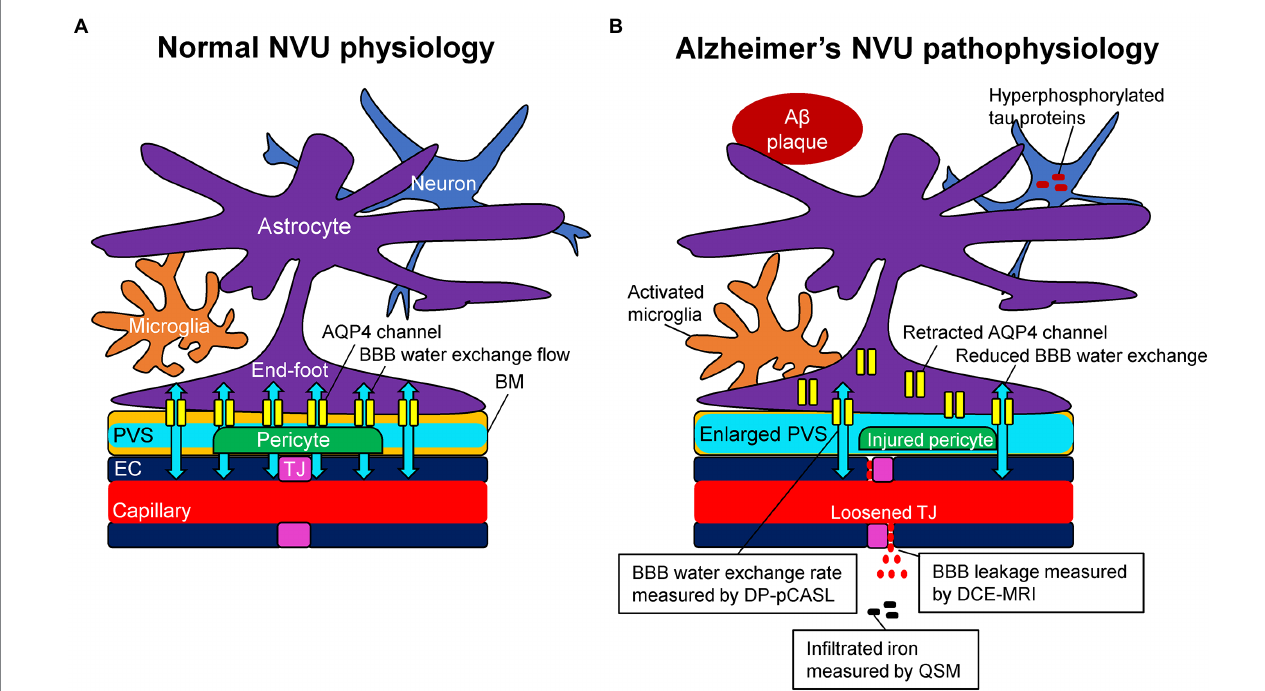
FIGURE 1 Schematic representation of the neurovascular unit (NVU) in normal physiology (A) and Alzheimer’s pathophysiology (B) . (A) The capillary lumen is formed by endothelial cells (EC), pericytes embedded in the basement membrane (BM), and astrocytic end-feet. Tight junction (TJ) proteins seal the ECs together and restrict the passage of solutes into the brain. The BM are separated into two layers, which are attached to the ECs and astrocytic feet, forming the perivascular space (PVS). Aquaporin-4 (AQP4) water channels expressed in the astrocytic end-feet membranes facilitate bidirectional water flow between the capillary, PVS, and interstitial tissues, resulting in the glymphatic flow. (B) In Alzheimer’s pathophysiology, the damaged TJ proteins loosen the seal of the ECs and provide a route for passive diffusion of toxic substances into the extravascular space, which can further damage or downregulate the NVU system. As a consequence of the injured pericyte that normally anchors the AQP4 water channels to astrocytic end-feet, the retraction of AQP4 from astrocytic end-feet membranes occurs with a reduction of bidirectional water flow, resulting in an enlarged PVS. Based on these pathophysiological changes, dynamic contrast-enhanced magnetic resonance imaging (DCE-MRI) can measure the blood–brain barrier (BBB) leakage, pseudo-continuous diffusion-prepared arterial spin labeling (DP-pCASL) can estimate the BBB water exchange rate, and quantitative susceptibility mapping (QSM) can detect the brain iron concentration,